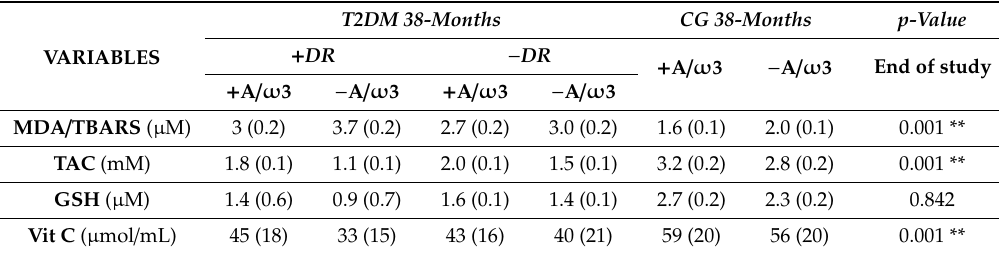
Table 5. Oxidative stress markers in the study participants.